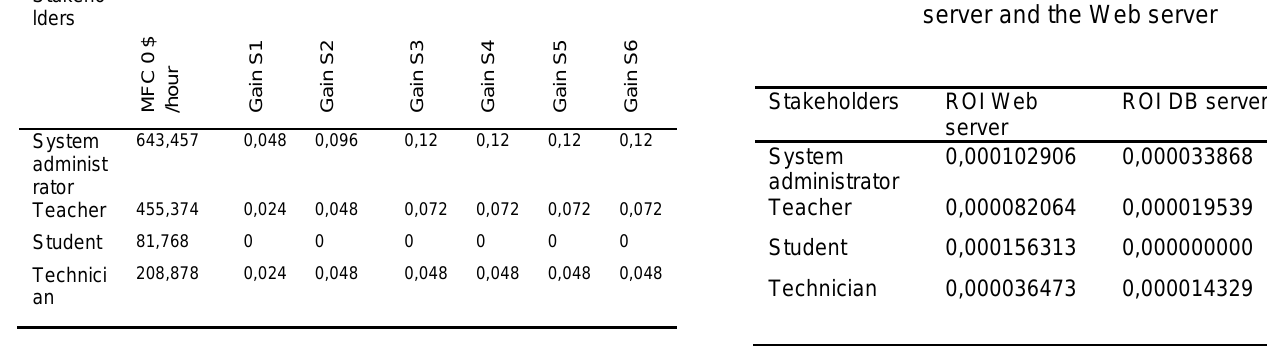
Table 18: The return on investment of the DB server and the Web